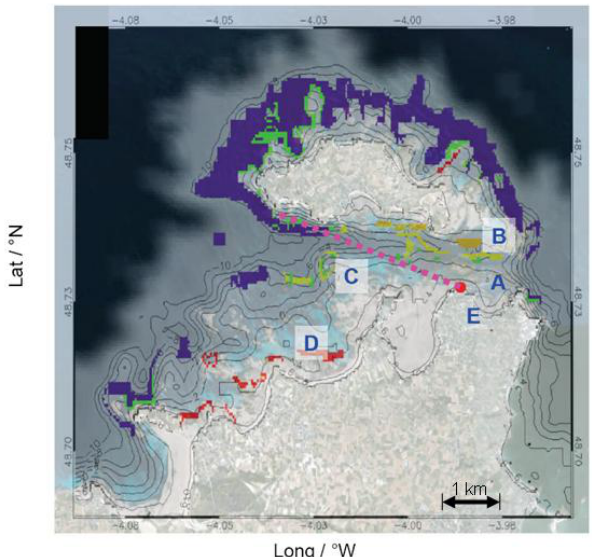
Fig. 1. Map of macroalgae for the Roscoff area. Known emitters of iodine species are Laminaria digitata (green), Laminaria hyperborea (purple), Laminaria ochroleuca (yellow), Laminaria saccharina (orange) and Ascophyllum/Fucus (red). The red dot marks the location of the LIF instrument. The dashed pink line represents the LP-DOAS light path. Letters refer to macroalgae areas referred to in the text.